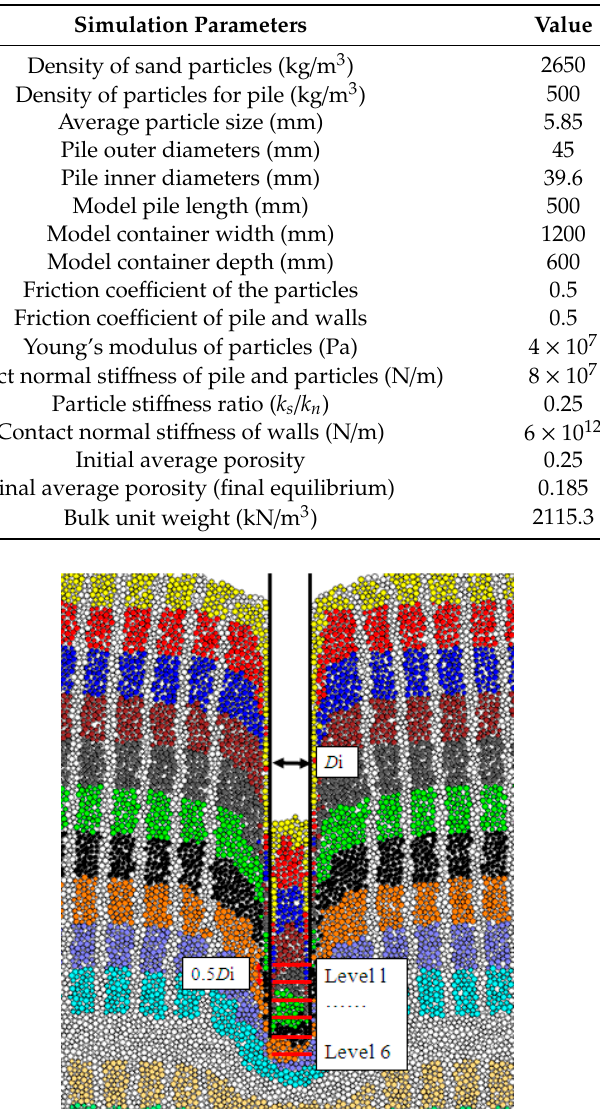
Table 1. Input parameters for discrete element method (DEM) simulations.